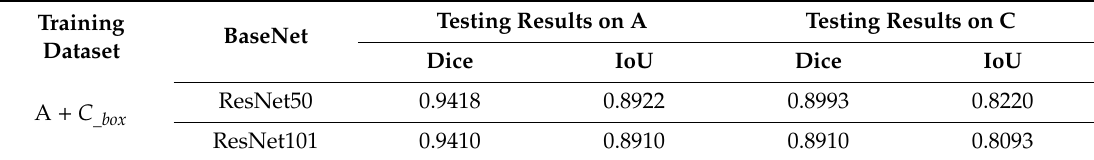
Table 5. Mask X R-CNN DIC / IoU scores obtained with datasets A and C _ box .